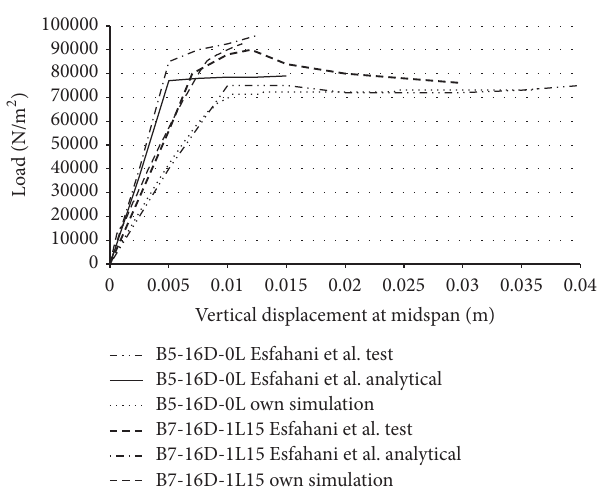
Figure 6: Load versus vertical displacement relationship for B5 and B7 Esfahani et al. specimens. Comparison of Esfahani et al. test results and analytical predictions with our simulations.